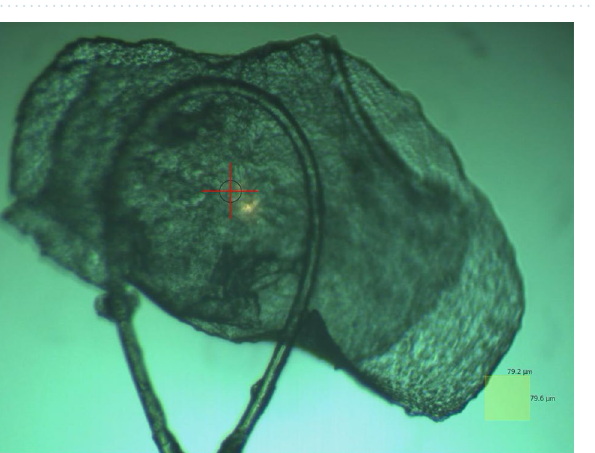
Figure 4. IR absorption from the core of Glycine 18 Hydroxy-glycine 4 Fe 2 O 4 . An absorption peak around 1651–8 cm −1 (6.0 µm), shown here at 1656 cm −1 is the typical “amide I” absorption for the backbone of the anti- parallel beta sheet 17 . This IR spectrum is typical of the core and of the pared down conformers. Molecule format is ball and spoke. Atom labels: hydrogen white, carbon black, nitrogen blue, oxygen red, iron green. Spartan ’20 Version 1.1.5 (220607) (Mac OS 12.5.1).